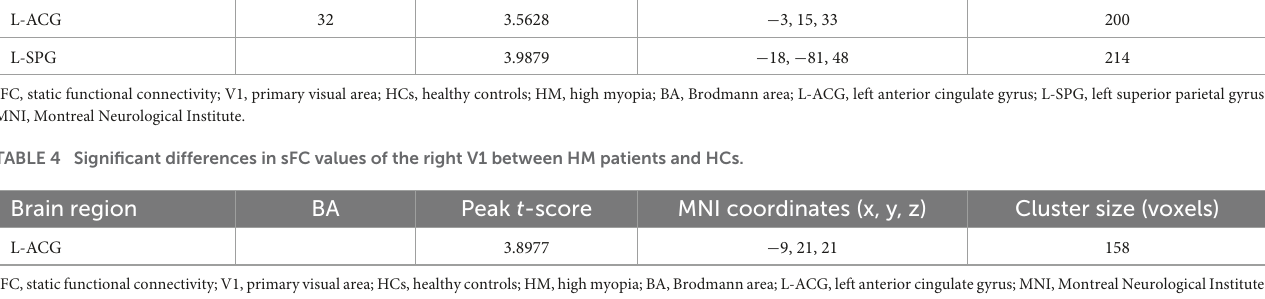
TABLE 3 Significant differences in sFC values of the left V1 between HM patients and HCs. Brain region BA Peak t -score MNI coordinates (x, y, z) Cluster size (voxels)